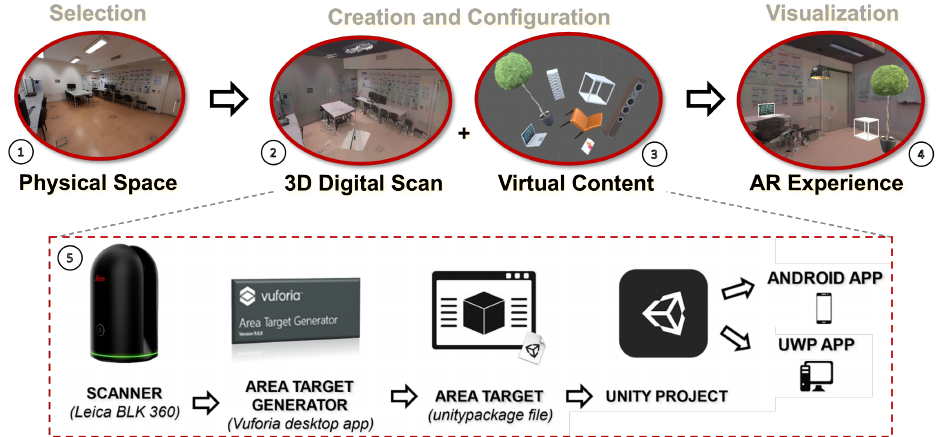
Figure 2. Creation process of pervasive AR experiences: 1. real-world environment; 2. reconstruction of the physical space; 3. integration of pre-existing augmented content according to the experience scope; 4. visualization of continuous AR-based content in the physical environment; 5. overview of the necessary steps to generate the